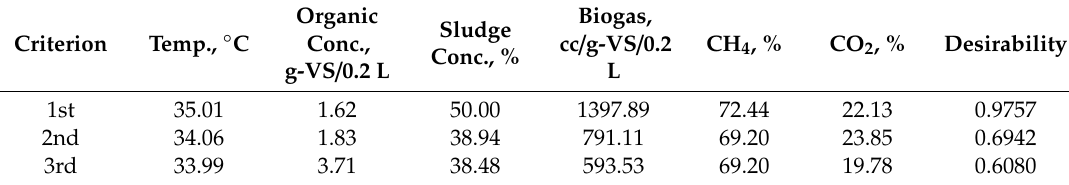
Table 9. The numerical optimisation results as obtained by the response surface methodology (RSM) based on the